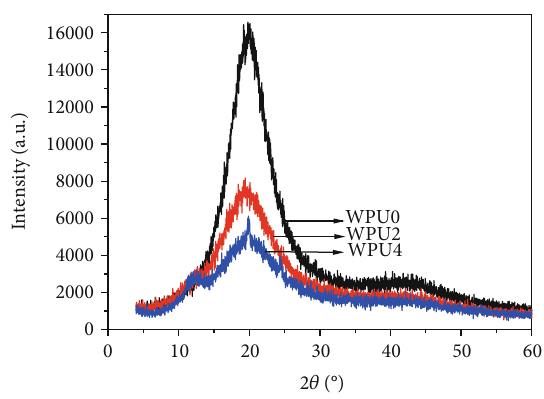
Figure 8: XRD patterns of LEPS-modi fi ed WPU fi